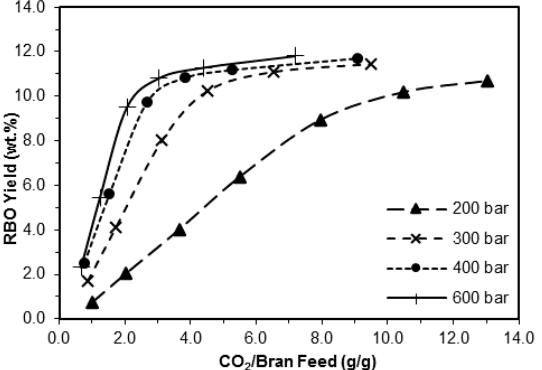
Figure 3. Supercritical fluid extraction yield of rice bran oil as a function of consumed CO 2 at different pressures (at 313 K, CO 2 flow rate of 1 L/min and using 20 g of rice bran loading).